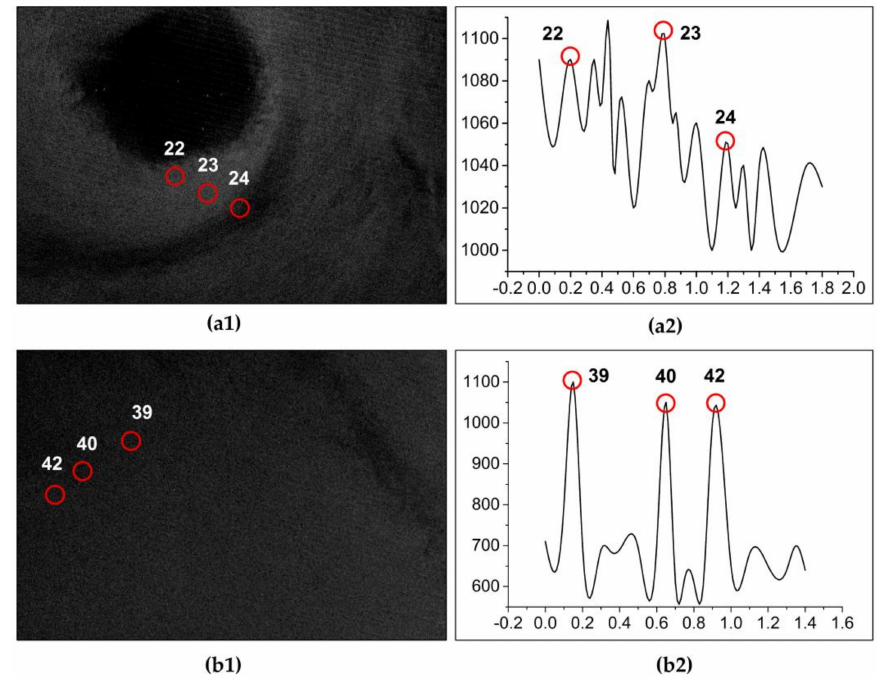
Figure 10. Image background histogram of the comparison results. ( a1 , b1 ) show the inhomogeneous and more homogenous background clutter of the synthetic aperture radar (SAR) image, respectively. ( a2 , b2 ) correspond to its background